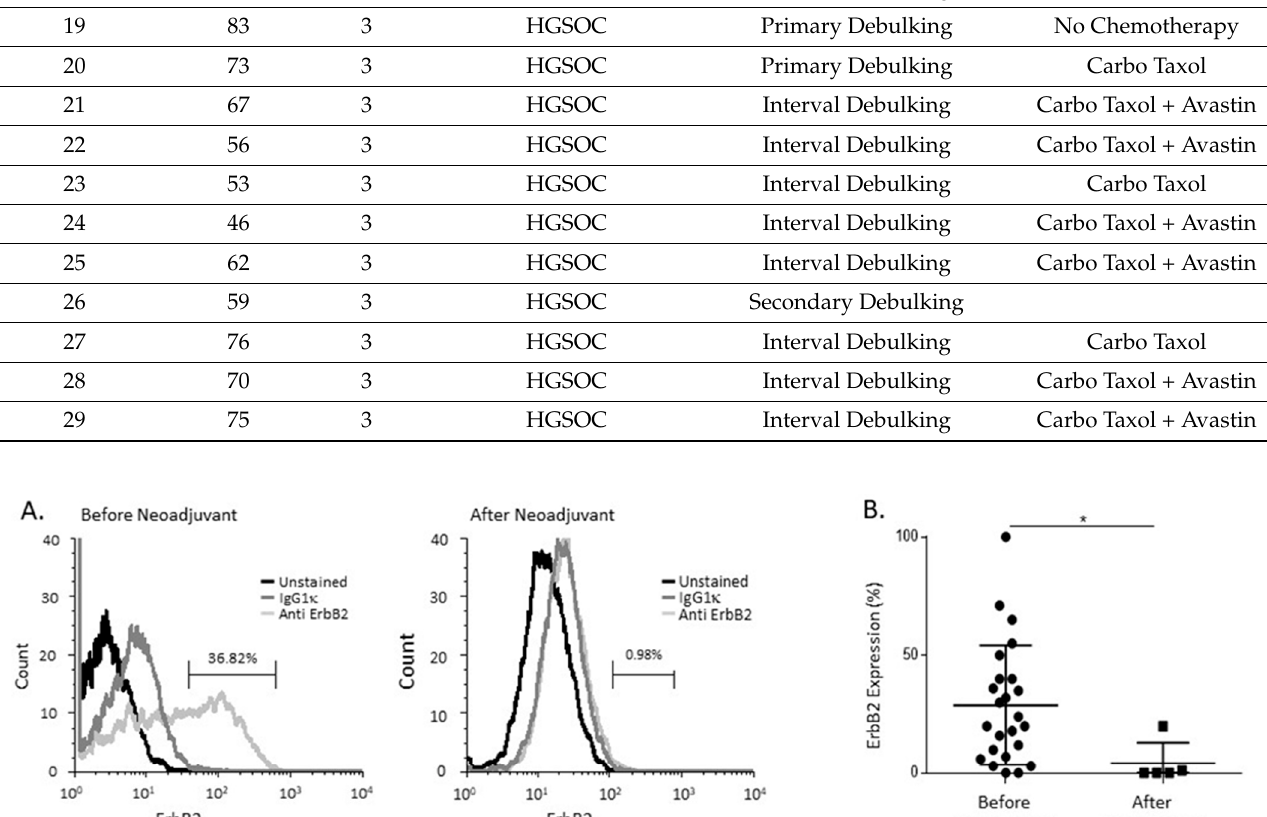
Figure 4. ErbB2CAR specifically promotes killing of primary ovarian tissues. Tissues were col ‐ lected from patients with HGSOC before and after neoadjuvant treatment and signal cell suspension was stained with anti ‐ human ErbB2 ‐ APC. mIgG1 ‐ APC was used for isotype control. The cells were analyzed by flow cytometry. ( A ) A representative flow cytometric analysis of samples from patients before neoadjuvant treatment ( left ) and after neoadjuvant treatment ( right ). ( B ) Summary of ErbB2 expression in 24 patients before neoadjuvant and 5 patients after neoadjuvant as analyzed by flow cytometry. Data were analyzed by Student’s t ‐ test before versus after neoadjuvant treatment * p < 0.05. ( C ) Seven tissues were randomly selected for further analysis by cResponse TM . Single cells were stained for anti ‐ human ErbB2 expression determined by flow cytometry (black bars). Histological sections were co ‐ cultured for 72 h with ErbB2CAR or UNT cells. Supernatants were collected and analyzed for IFN γ secretion as determined by ELISA (gray bars), and H and E staining determined tissue viability after treatment. The score was calculated as described in Materials and methods. The viability of the cancer cells was calculated as the delta score of ErbB2CAR treatment and of UNT treatment (black line). ( D ) Representative staining with H&E (top panel) and cleaved Caspase 3 (bottom panel) of HGSOC tissue after co ‐ culture with ErbB2CAR or UNT cells for 72 h. ( E ) Fold